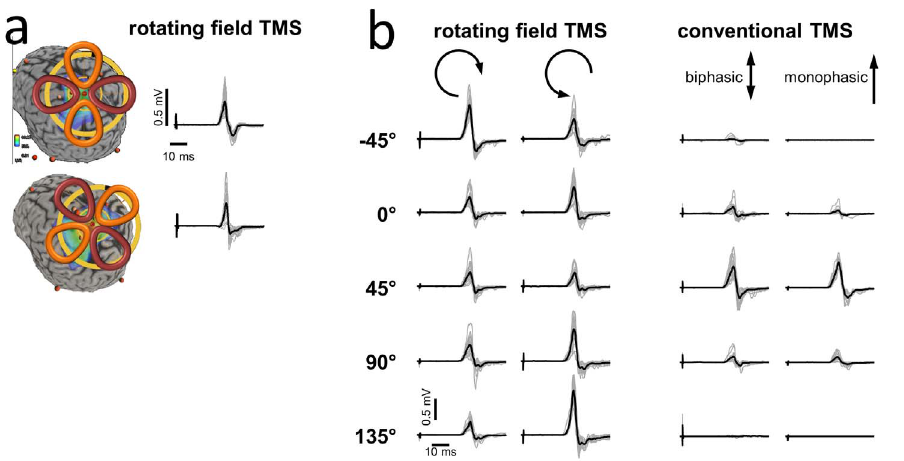
Figure 6. The response of Human motor cortex to rfTMS. a) The cloverleaf coil is positioned over the motor cortex. Stimuli with constant strength are applied at 0.2 Hz. Individual muscle evoked potentials recorded from the first dorsal interosseous are shown in grey, and the averaged response in black. Rotating the coil by 50 u in the plane of the cloverleaf coil and maintaining the center position does not change the amplitude of the muscle response. Data obtained from subject A.N. b) Extended experiment, testing 5 different orientations, controlled by a robotic device. For each orientation two opposite rotation directions of the rotating field were tested. The experiment was then repeated using a standard figure-eight coil, used to apply both biphasic pulses, as in rfTMS, and mono-phasic pulses. Under standard TMS no muscle response can be detected for orientations more than 45 u away from the optimum. In contrast, rfTMS provides reliable stimulation independent of the coil’s orientation. Data obtained from subject W.P.